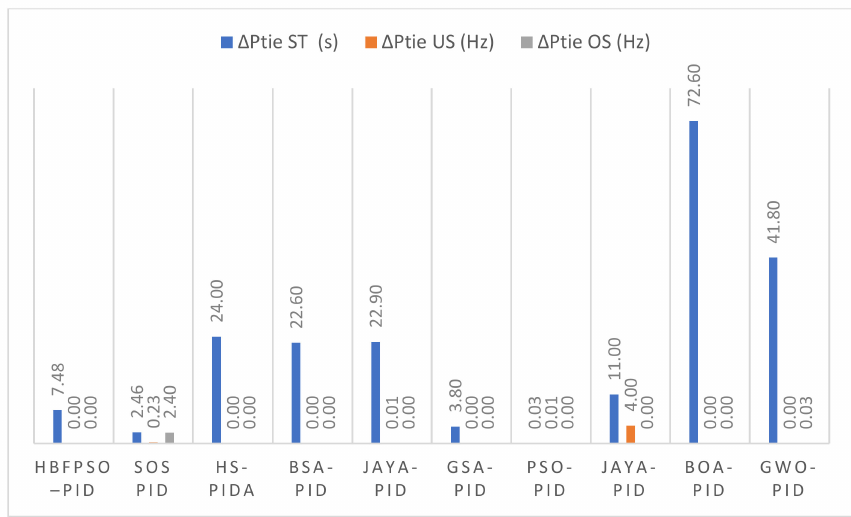
Figure 8. Frequency Deviation for Interconnected